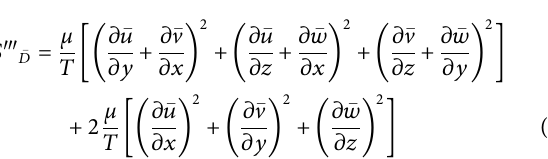
Frontiers in Energy Research |